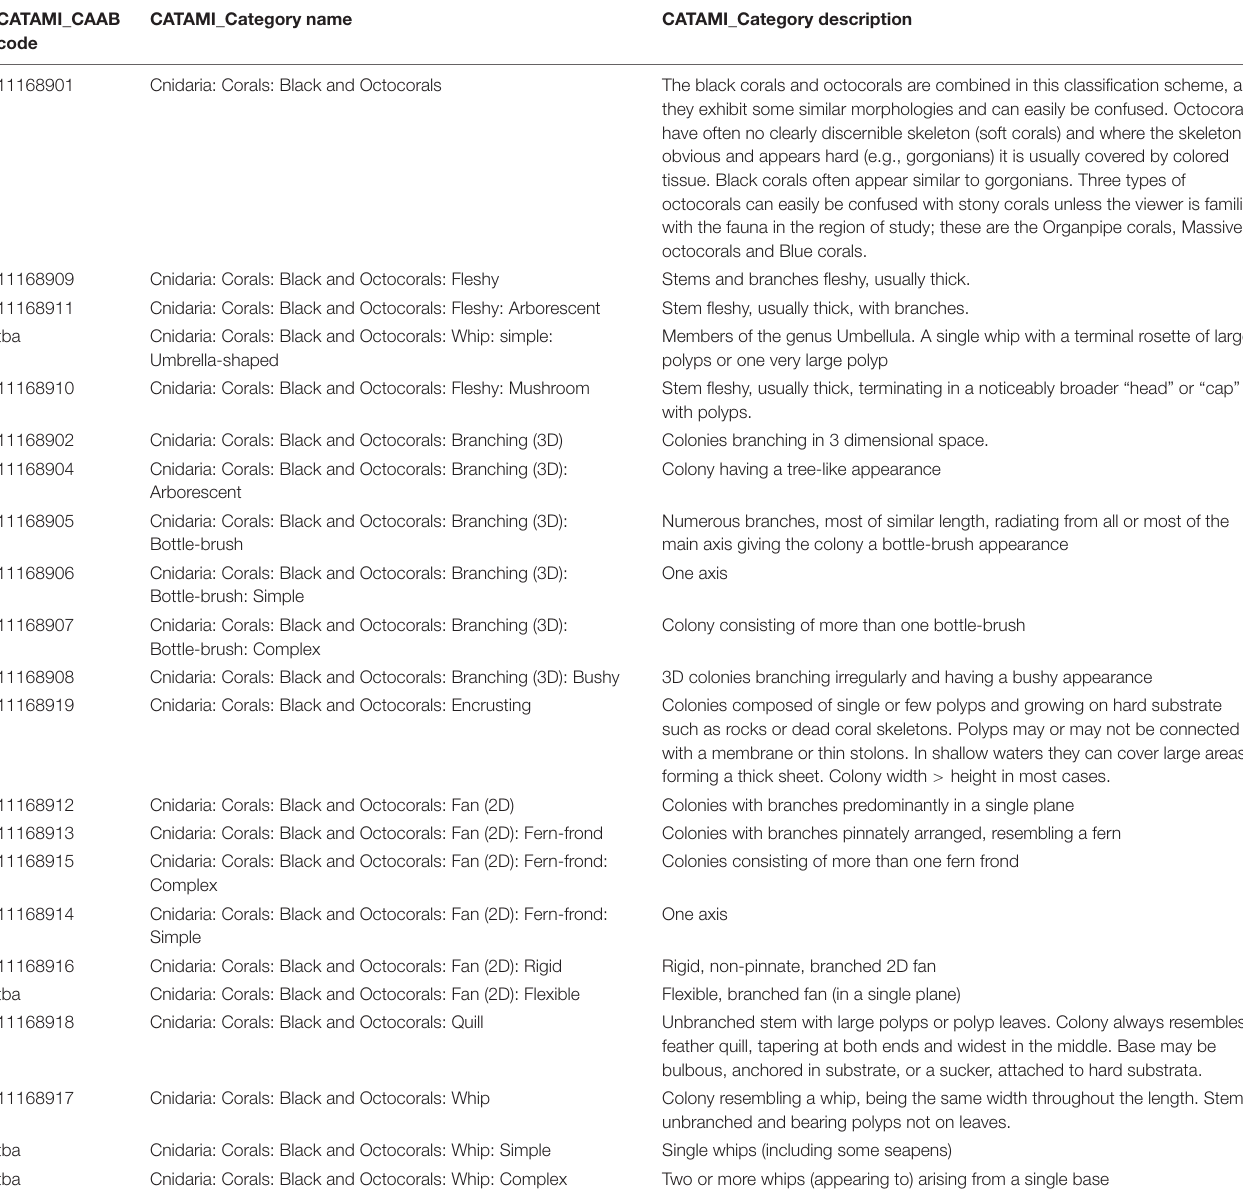
TABLE 1 | Details of CATAMI categories used in the annotation of “black and octocorals” with updated and revised